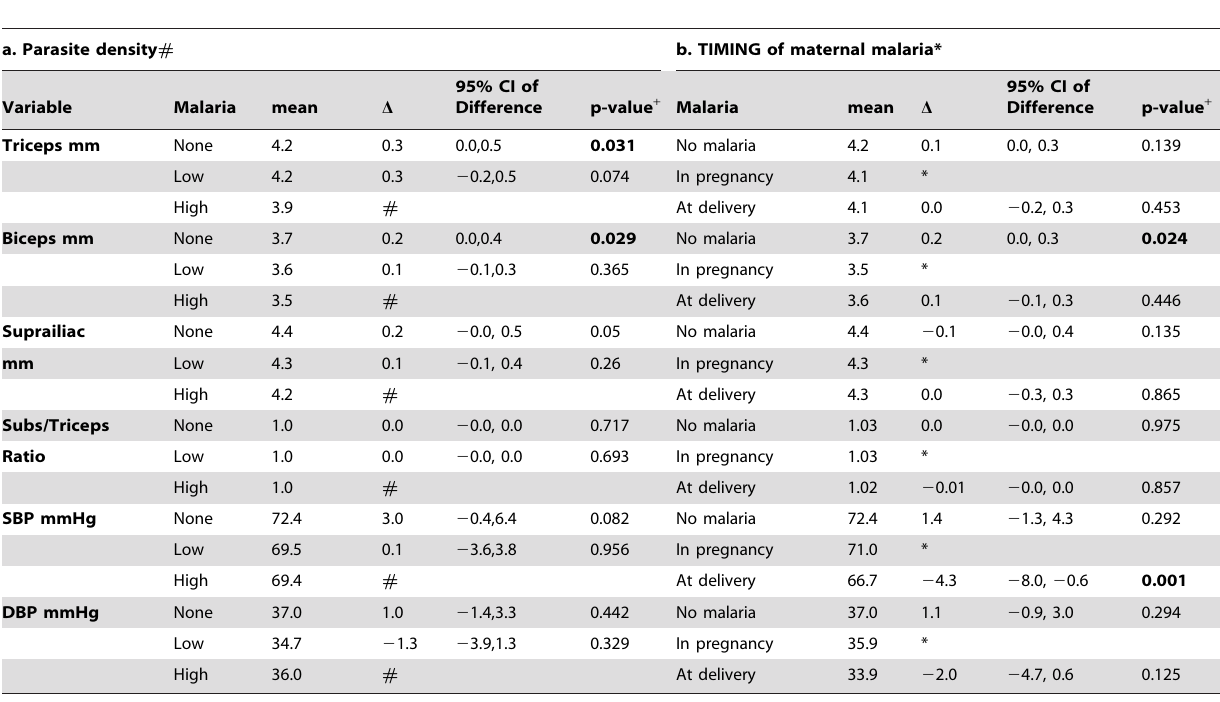
Table 4. Associations between growth characteristics and blood pressure at birth defined by Parasite density and Timing of Malaria.